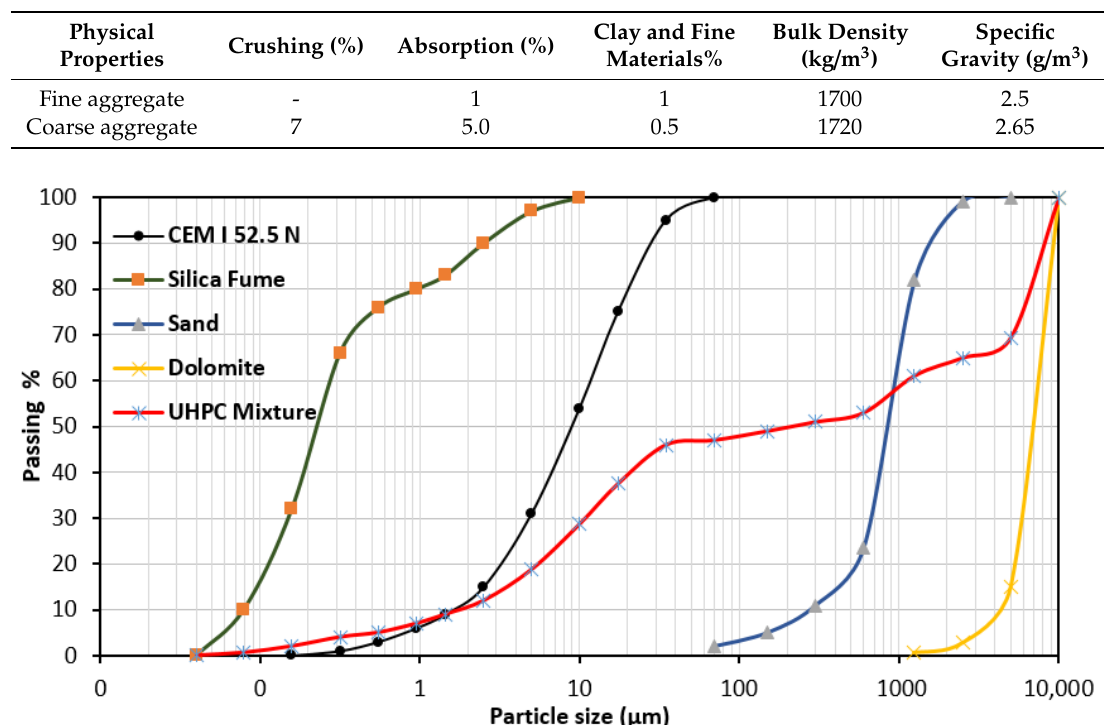
Figure 1. Particle size distribution of cement and silica fume.